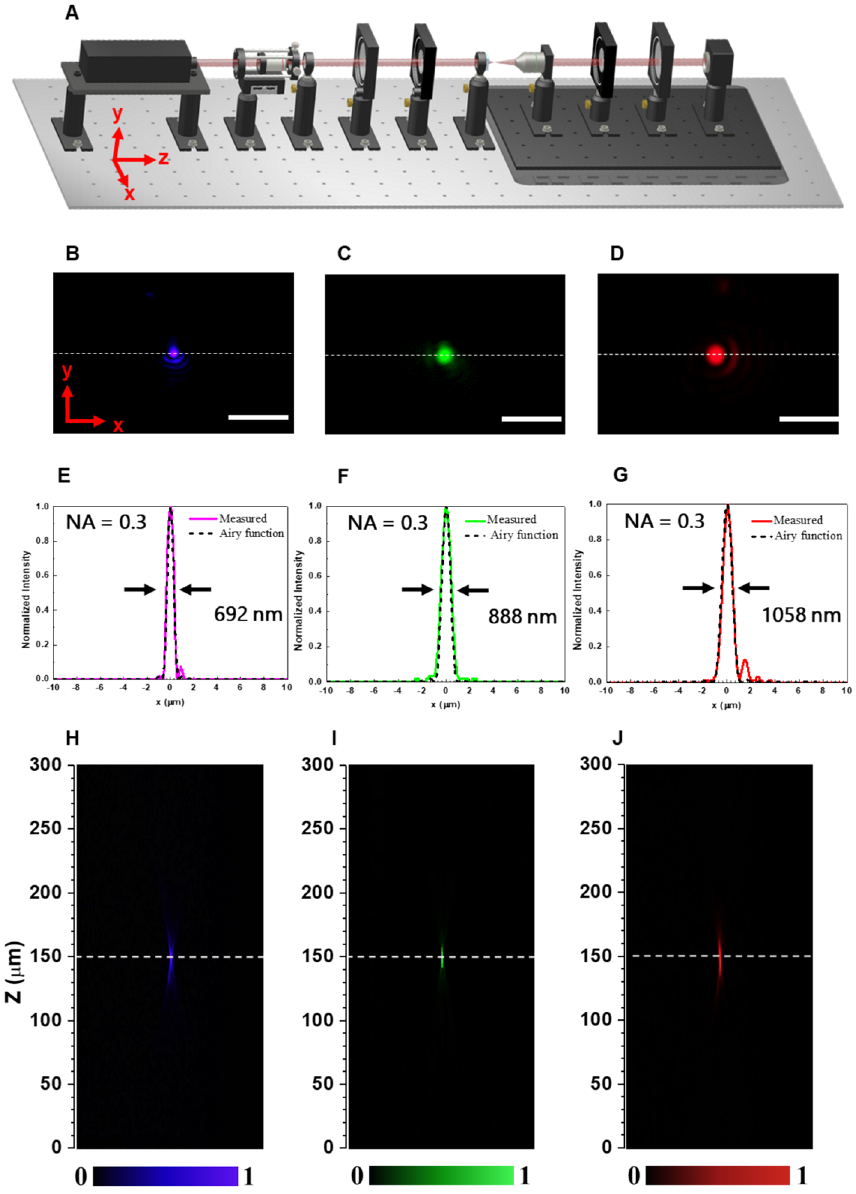
bar: 5 μm. ( E – G ) Corresponding horizontal cuts of focal spots with FWHM of 692, 888, and 1058 nm. Dashed lines referring to normalized ideal Airy function. ( H – J ) Intensity profiles of the metalenses along axial planes designed at wavelengths of ( H ) 405, ( I ) 532, and ( J ) 633